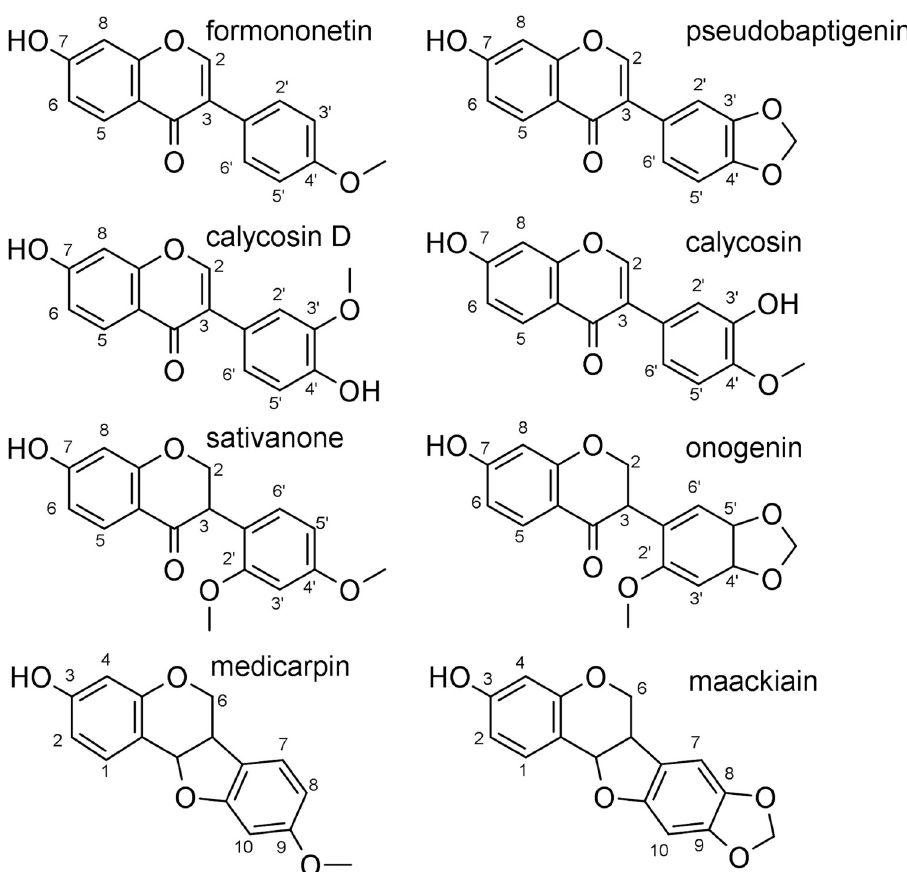
Fig 1. The structure and numbering of the investigated isoflavonoid